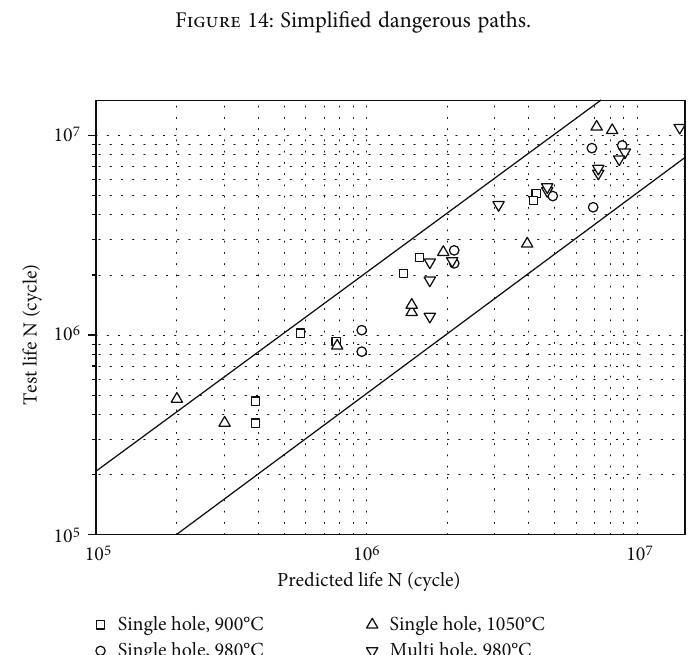
Figure 15: Cycle life comparison between prediction and test.